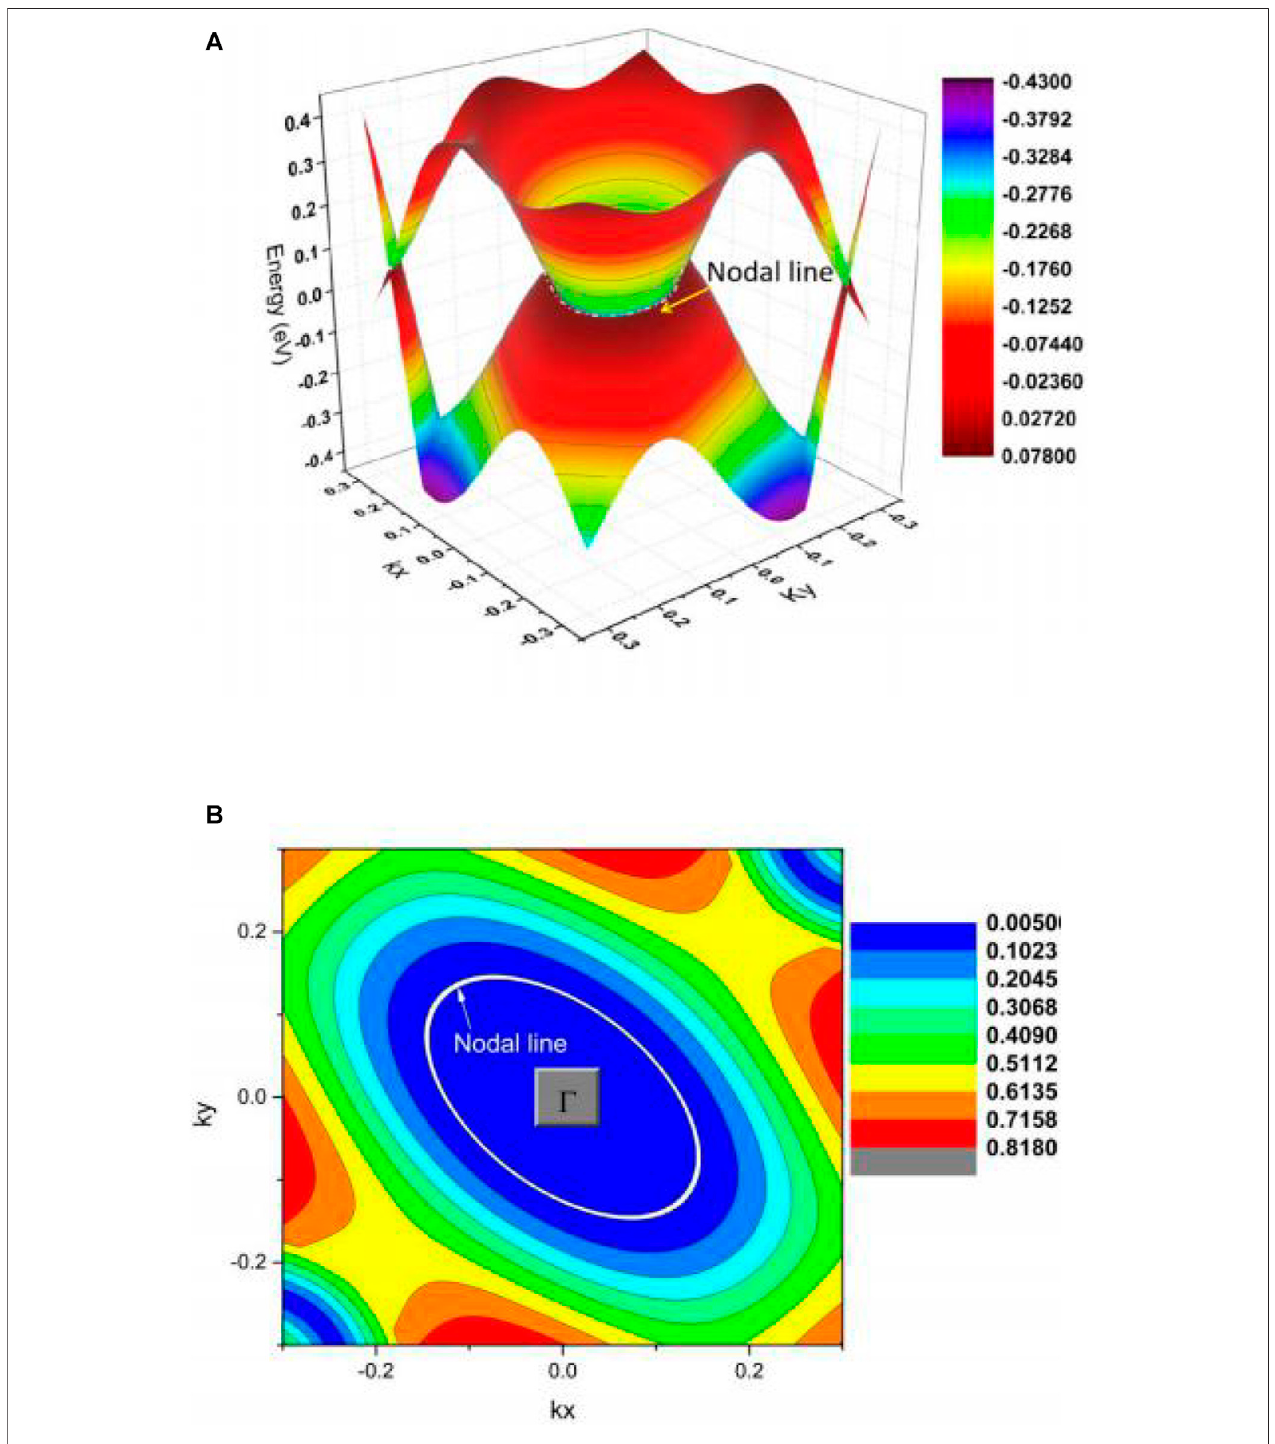
FIGURE 6 | (A) Γ -centered 3D band dispersion in region B of the kz (cid:1) 0 plane and (B) shape of the NL in region B of the kz (cid:1) 0 plane.